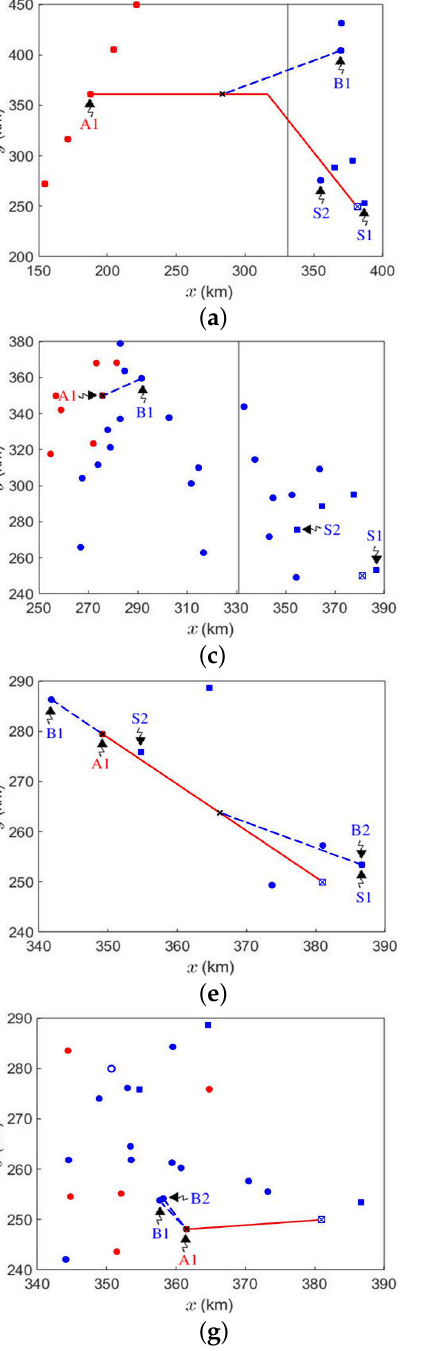
Figure 14. Scenario in case 3 on ζ 2 , against slant formation, ( a ) t = 0 s; ( b ) t = 40 s; ( c ) t = 280 s; ( d ) t = 300 s; ( e ) t = 580 s; ( f ) t = 640 s; ( g ) t = 700 s; ( h ) t = 760